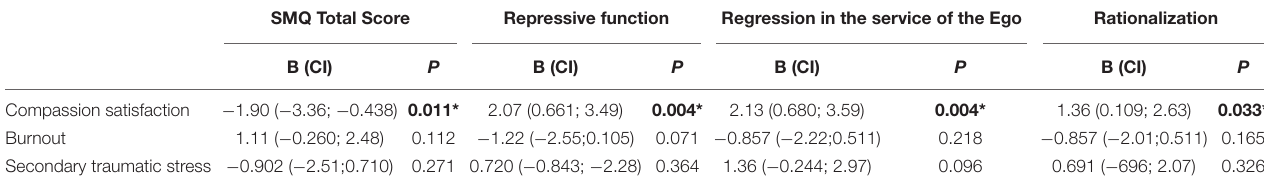
TABLE 5 | Multivariate linear regressions